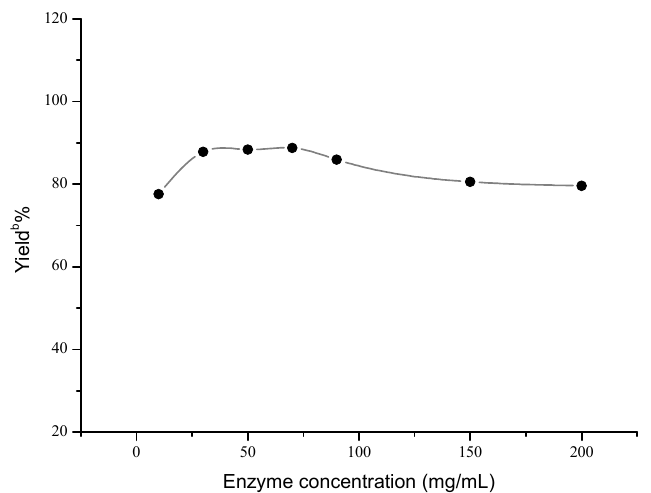
Figure 1. Influence of enzyme concentration on the Henry reaction a .